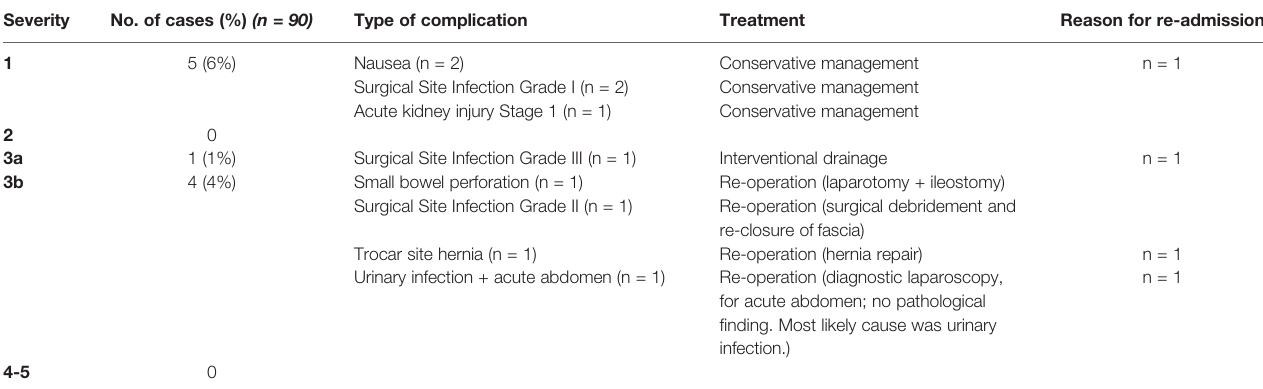
TABLE 3 | Postoperative complications and re-admissions after PIPAC treatments. Severity No. of cases (%) (n =